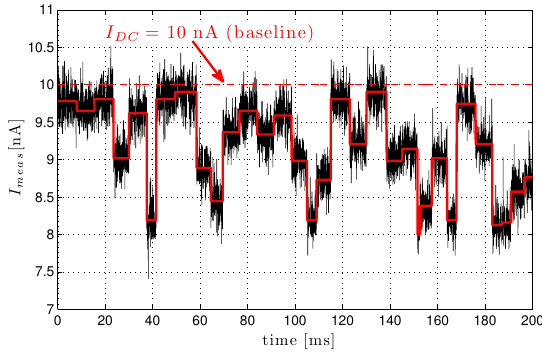
Figure 5. Example illustration of modulated current through a